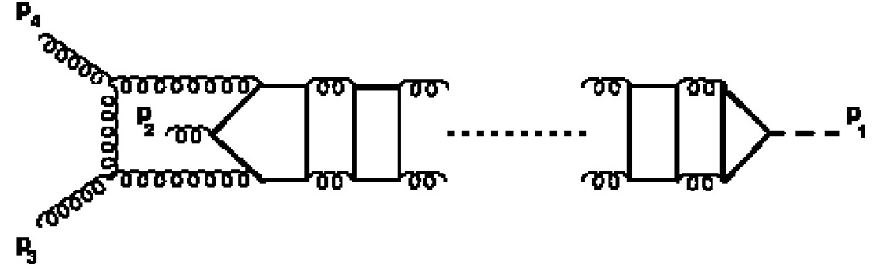
Figure 29. Non planar (2+2 n )-loop contribution to H + j